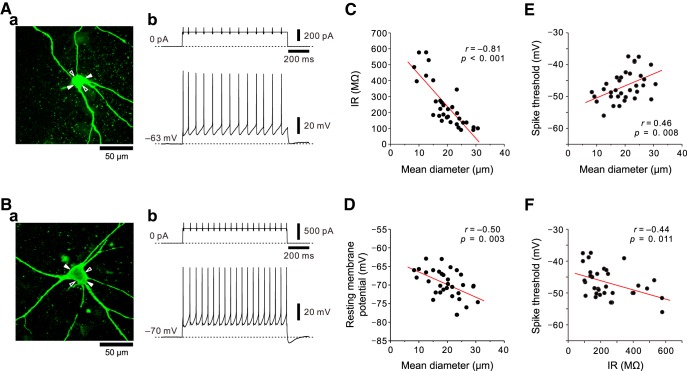
Relationships between the sizes of MNs in the dl-TMN and IRs, resting membrane potentials, or spike thresholds. Aa, Ba, Small (19 × 17 μm) and large (30 × 21 μm) MNs filled with biocytin (Aa and Ba, respectively). The minor and major axes are indicated with open and filled arrowheads, respectively. Ab, Bb, Membrane potential responses to depolarizing current pulses applied to small and large MNs at the resting membrane potential (Ab and Bb, respectively). C, The inverse relationship between the sizes of MNs and IRs (n = 33). D, The inverse relationship between the sizes of MNs and resting membrane potentials (n = 33). E, The positive relationship between the sizes of MNs and spike thresholds (n = 33). F, The inverse relationship between the IRs and spike thresholds (n = 33).